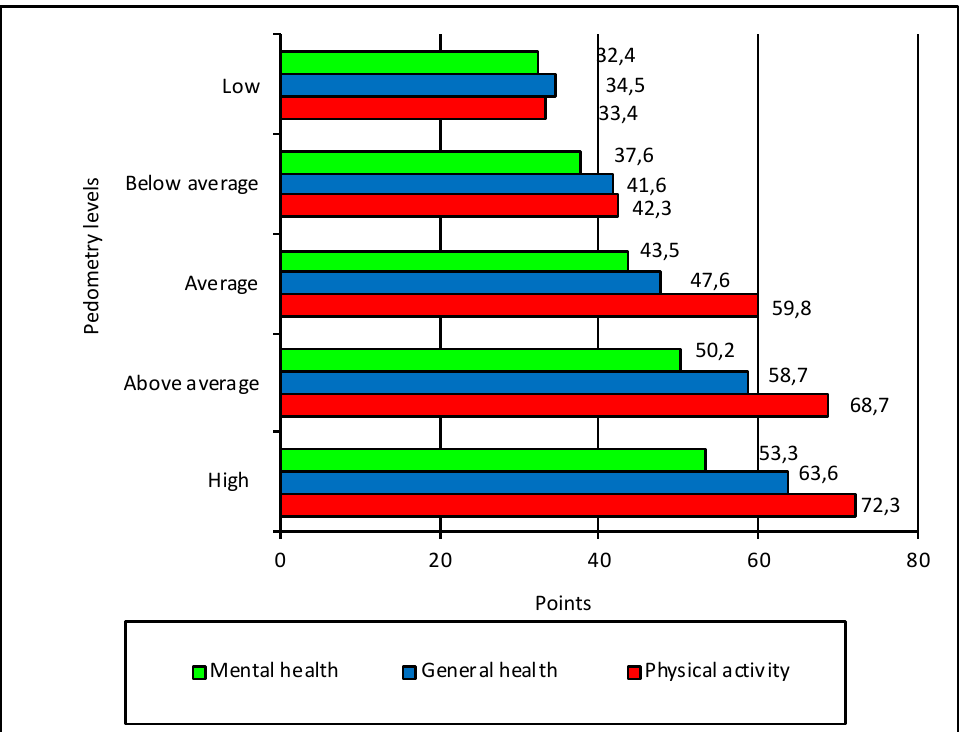
Figure 5. Life quality components of females with different levels of pedometry (in